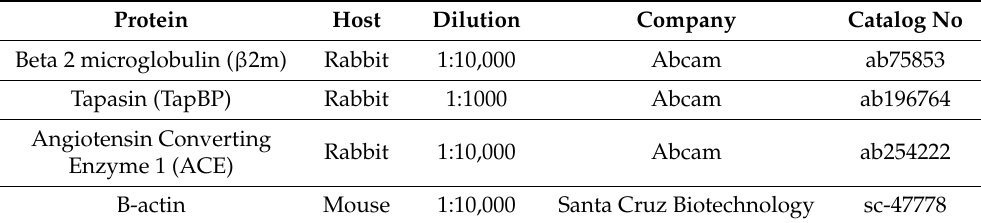
Table 2. List of antibodies used for Western